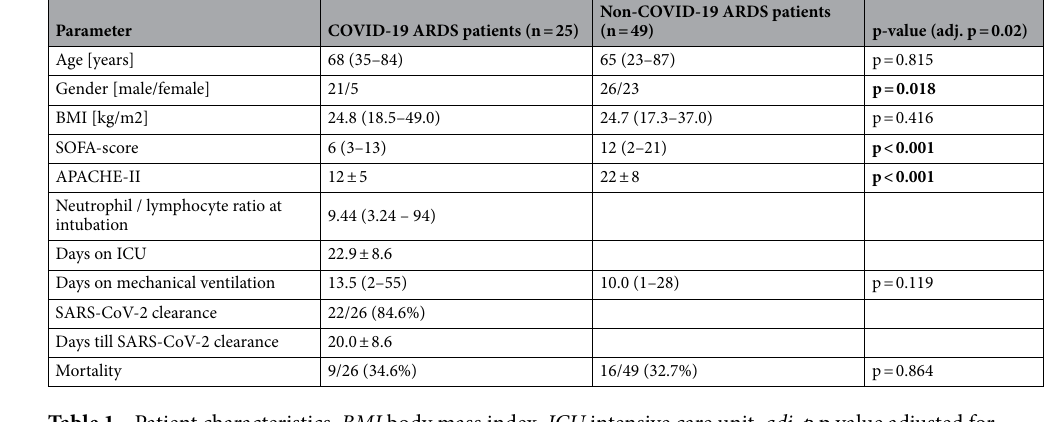
Table 1. Patient characteristics. BMI body mass index, ICU intensive care unit, adj. p p value adjusted for multiple testing, significant p-values are displayed in bold